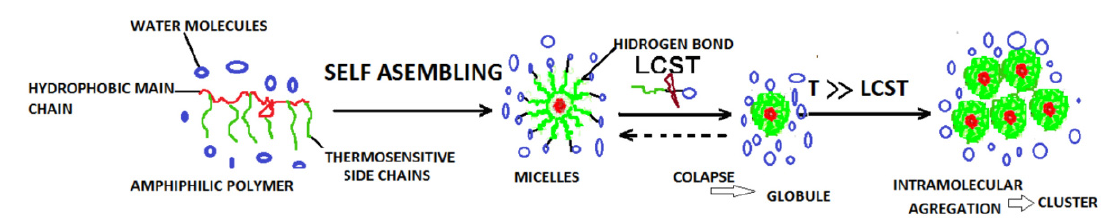
Figure 8. The proposed mechanism taking place around LCST for the analyzed